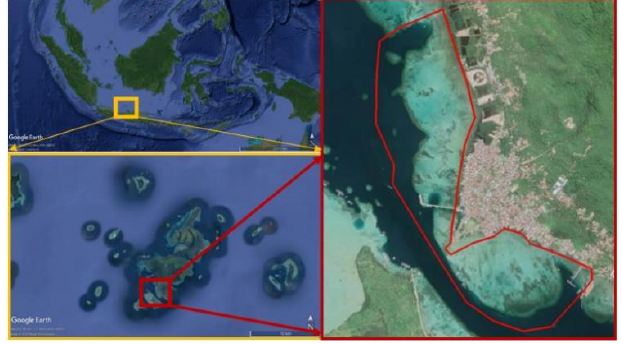
Fig.1. Location of the research